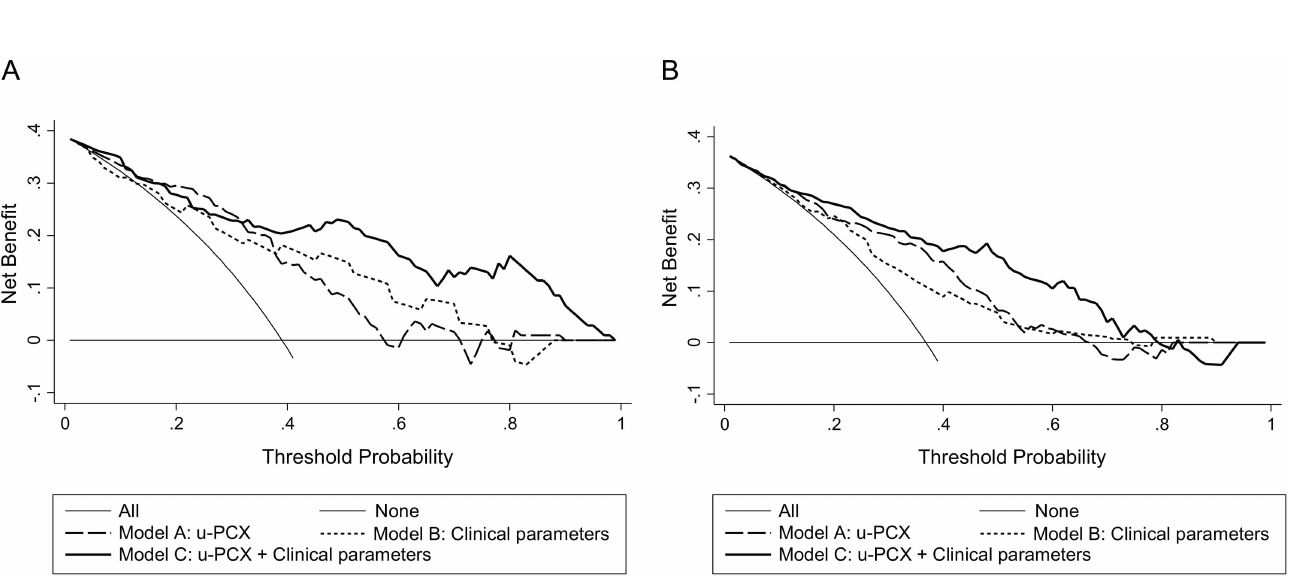
PLOS ONE | DOI:10.1371/journal.pone.0163507 September 26,